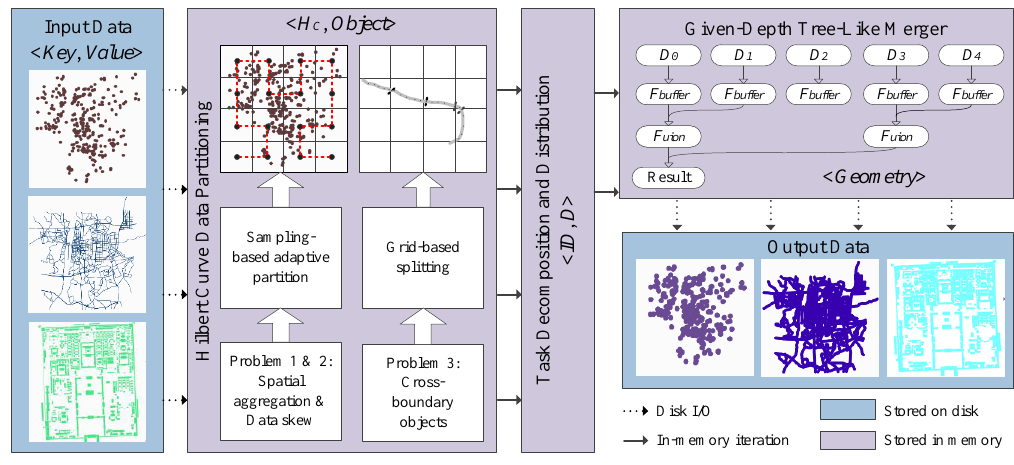
Figure 3. Framework of